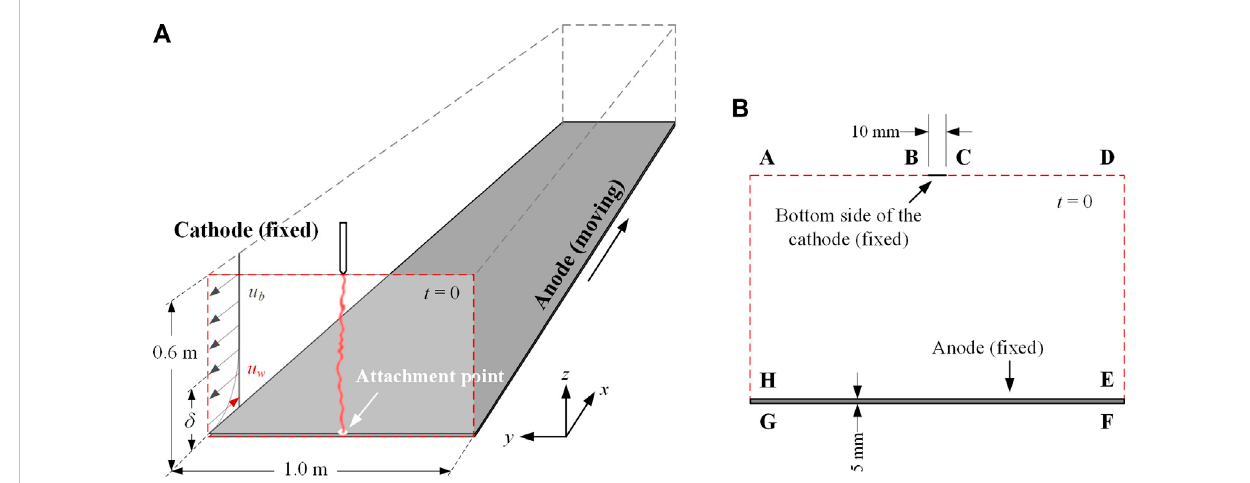
FIGURE 2 Calculation domain (not to scale) of: (A) dynamic arc model, and (B) static arc model.